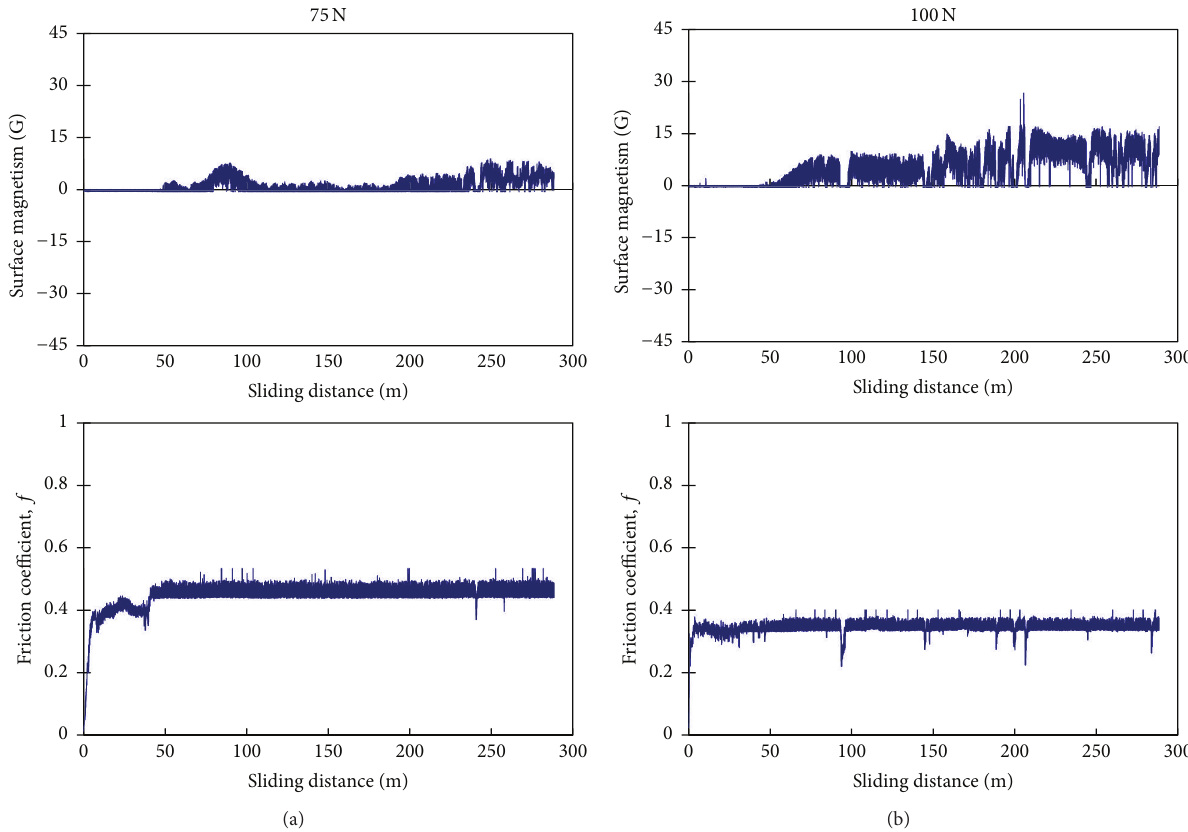
Figure 4: Surface magnetization and friction coefficient responses for SCM415 with Carburizing-Deep cryogenic treatment-Tempering: (a) 75 N and (b)